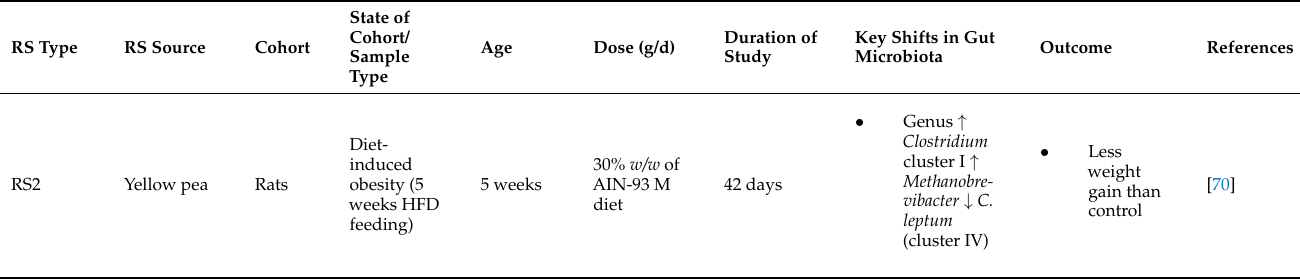
Table 2. Effect of dietary pulses-derived resistant starches in modulating gut microbiota and related health